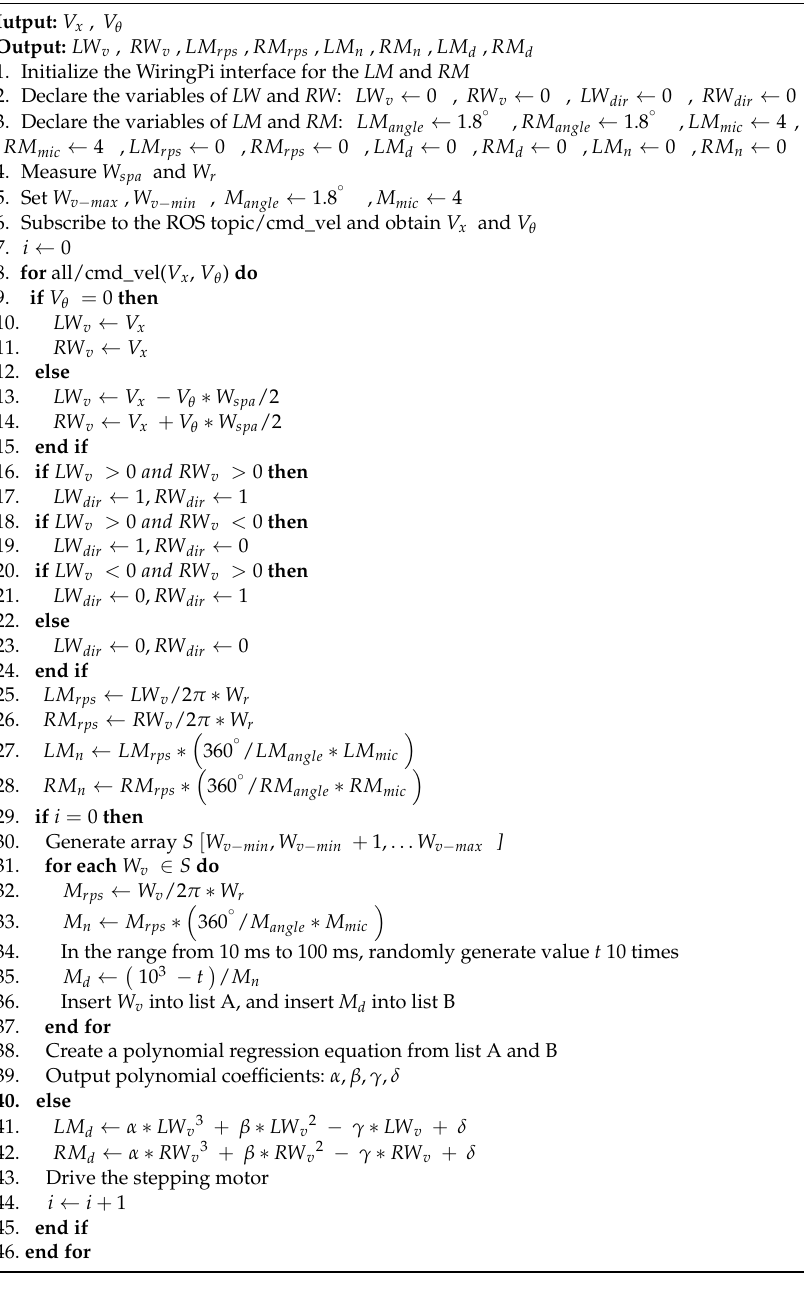
Algorithm 1: Proposed stepping motor control